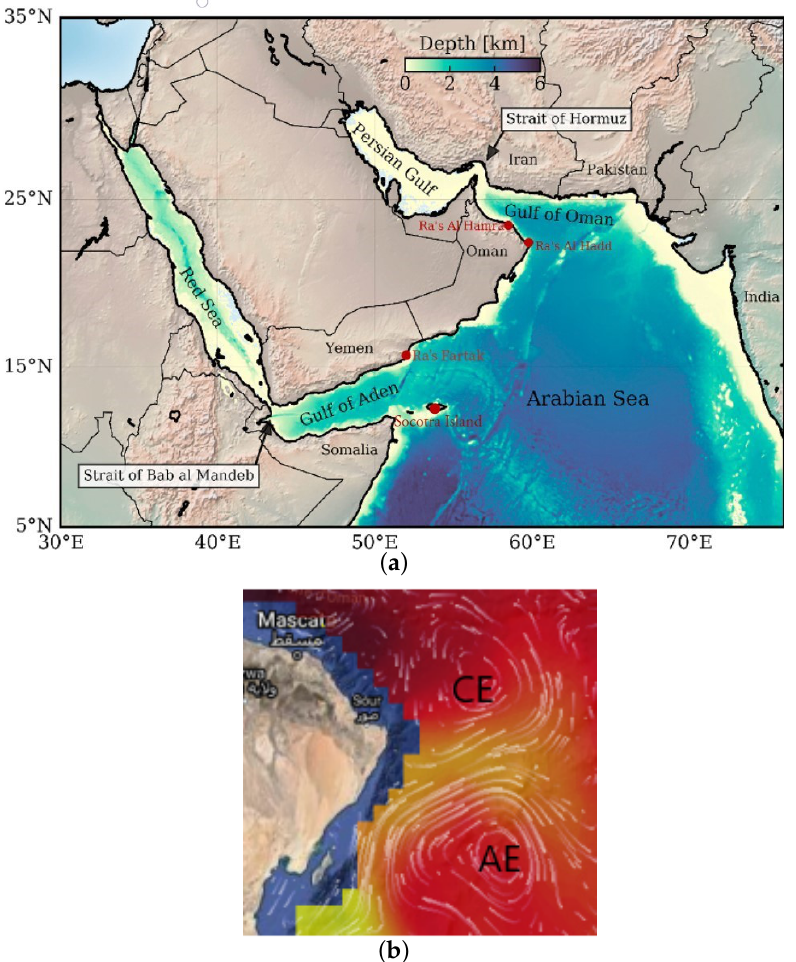
Figure 1. ( a ) Bathymetry of the Arabian Sea and its marginal gulfs from the ETOPO2 database [3]. ( b ) Snapshot of the Ras al Hadd dipole in summer 2020 with the cyclone to the northeast and the anticyclonetothesouthwest(fromtheOceanVirtuallaboratoryweb portal(ESA,OceanDataLab, accessed on 1 December 2020)